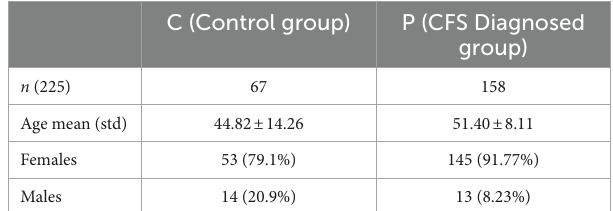
TABLE 1 Sample analysis.